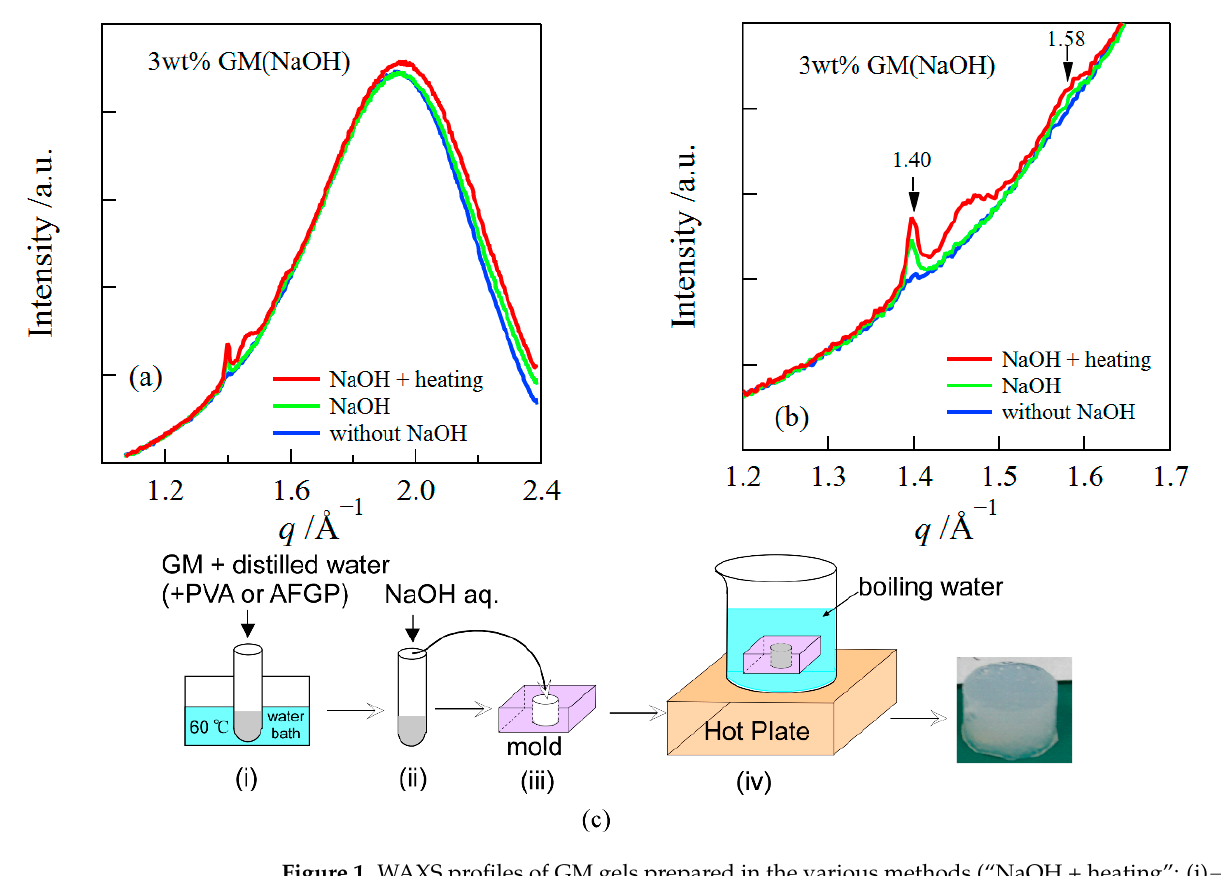
Figure 1. WAXS profiles of GM gels prepared in the various methods (“NaOH + heating”: (i) − (iv), “NaOH”: (i) − (iii), “without NaOH”: (i) + (iii)) ( a ). The magnification around the crystalline peaks ( b ). A flow diagram of the sample preparation ( c ).